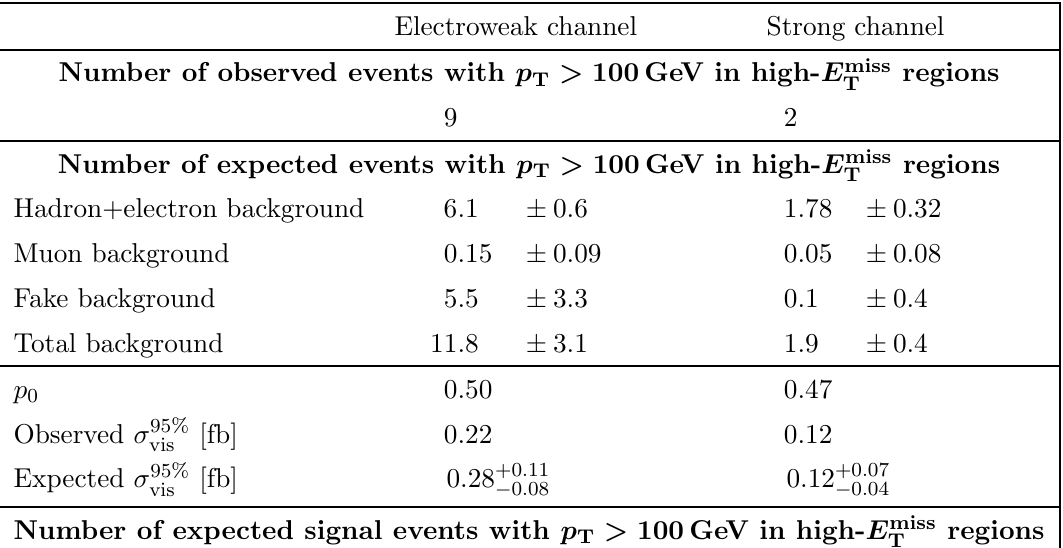
Table 4 . Observed events, expected background for null signal, and expected signal yields for two benchmark models: electroweak channel with ( m with ( m ~ g ; m ; (cid:28) ) = (1600 GeV ; 500 GeV ; 0 : 2 ns) in the high- E miss ~ (cid:31) (cid:6) 1 ~ (cid:31) (cid:6) 1 probability of a background-only experiment being more signal-like than observed ( p 0 ) and